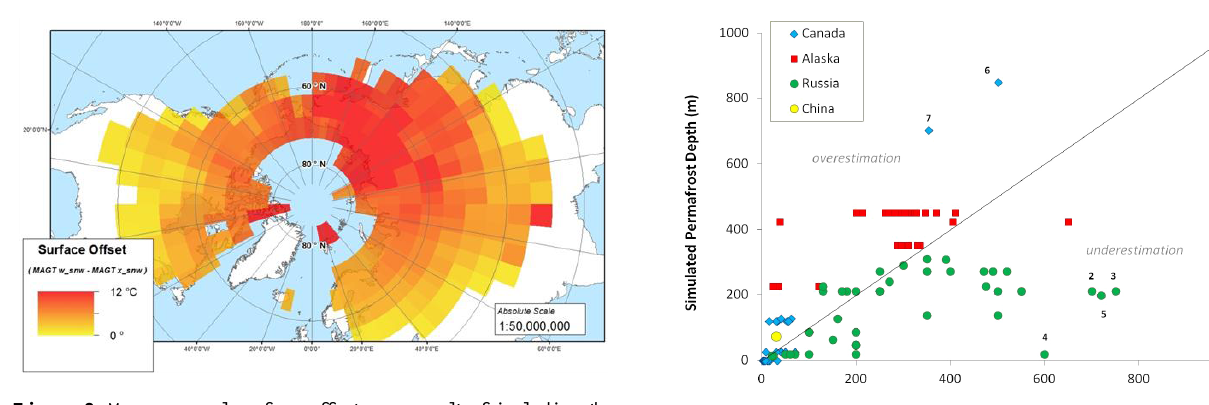
Figure 8. Mean annual surface offset as a result of including the snow option.